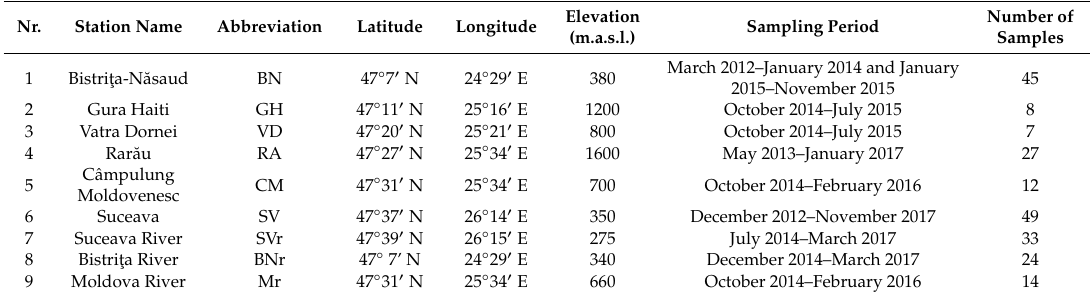
Table 1. The name of the precipitation and rivers of the study sites, with corresponding abbreviation, coordinates, elevation, study period and number of samples for each